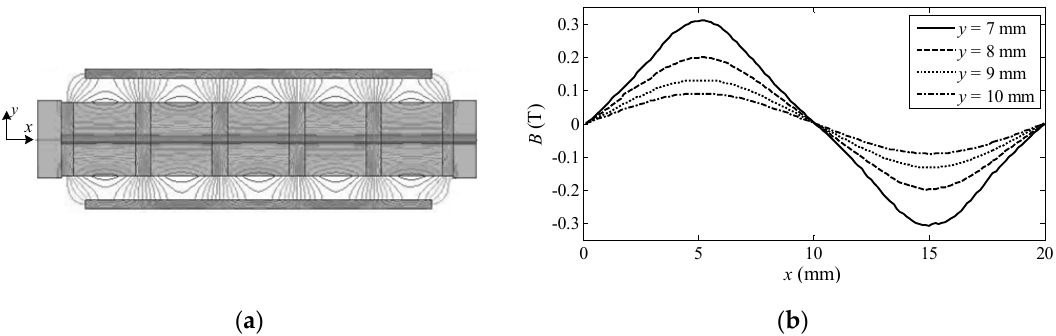
Figure 3. ( a ) FEM simulation result of magnetic line distribution; ( b ) Distribution curves of magnetic field strength at different radial distances.